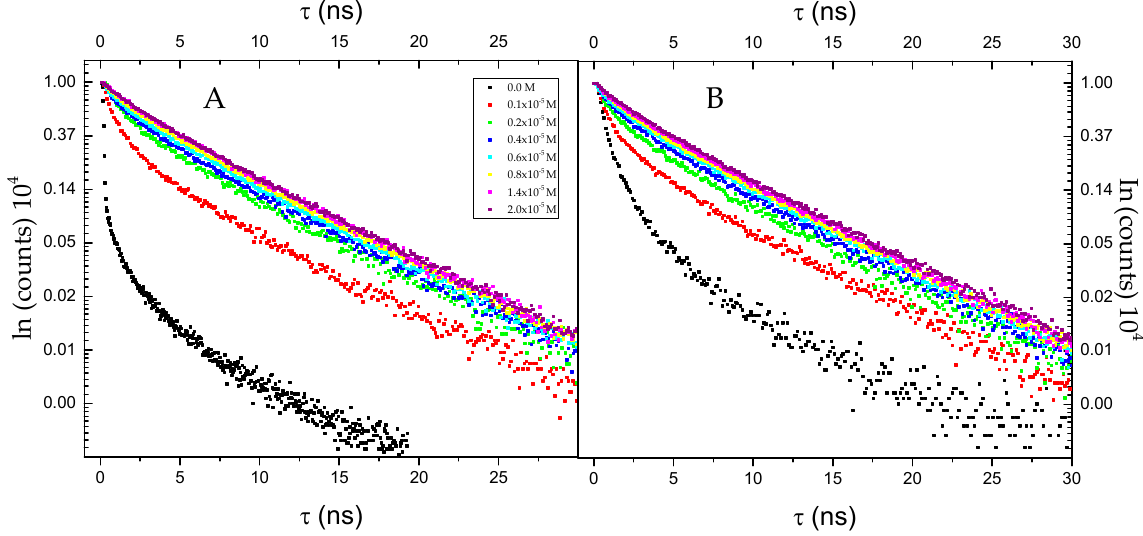
Figure 3. Fluorescence decay profiles of I ( A ) and II ( B ) in absence and different concentration of BSA (0.0 M, 0.1 × 10 − 5 M, 0.2 × 10 − 5 M, 0.4 × 10 − 5 M, 0.6 × 10 − 5 M, 0.8 × 10 − 5 M, 1.4 × 10 − 5 M, 2.0 × 10 − 5 M). For the molecule I in the phosphate buffer medium, the fluorescence decay profile can be satisfactorily fitted by monoexponential function with the fluorescence decay time τ 1 ~200 ps (Table 1), in the presence of BSA at low concentration (10 − 6 –6 × 10 − 6 M), the sum of two exponential functions was required, whereas at the highest concentration (8 × 10 − 6 –2 × 10 − 5 M), again only one emissive centre was observed ( τ 3 ~5.7 ns) (Figure